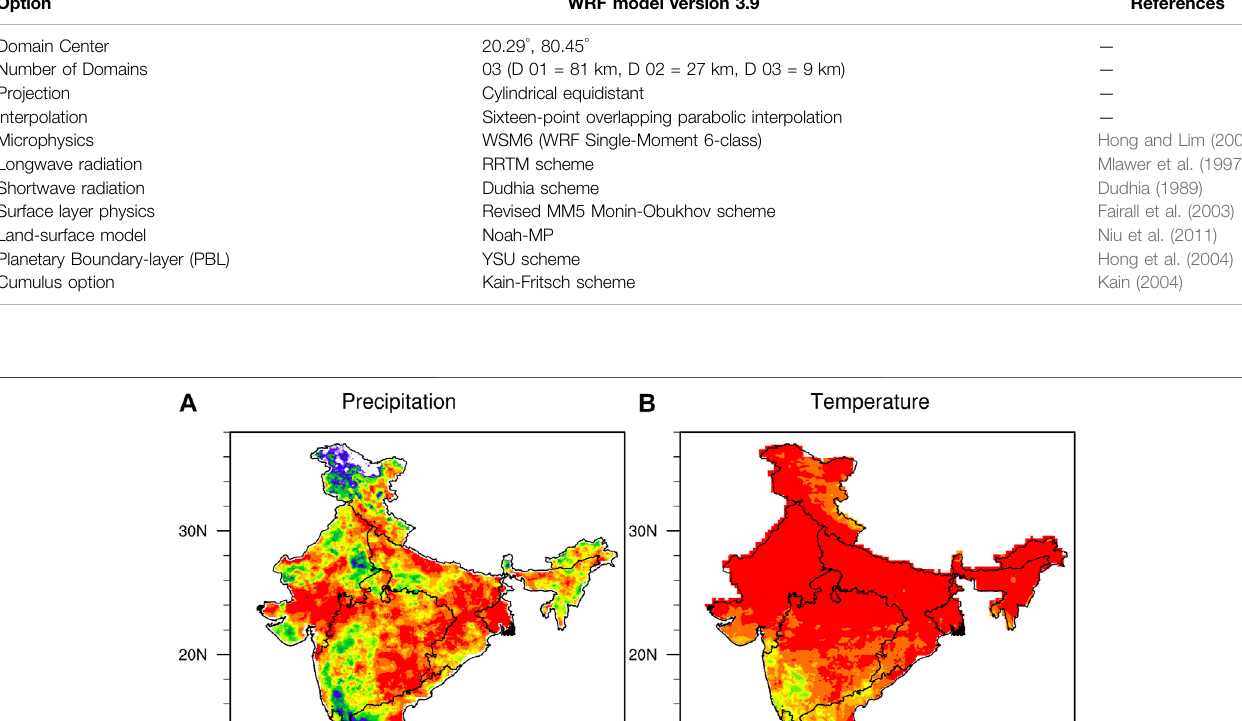
Frontiers in Environmental Science |